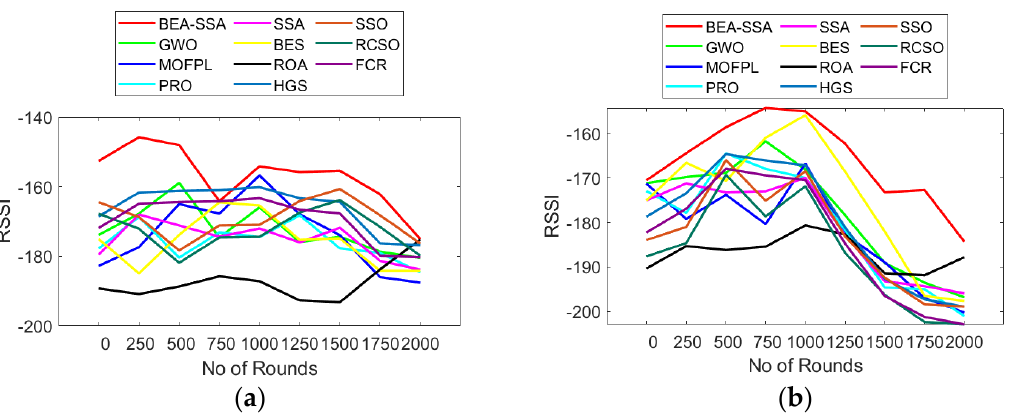
Figure 8. RSSI analysis using BEA ‐ SSA compared with the other models [20–22,26] for node counts of ( a ) 100 and ( b ) 200.